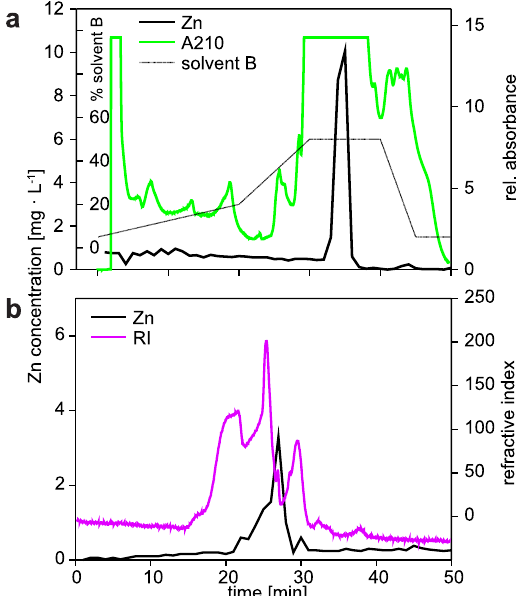
Figure 4. HPLC separation profile with ( a ) NH 2 -column of pooled zinc-containing low molecular weight fractions of gel chromatography showing absorptions at 254 nm (green line), Zn concentration (thick black line) and solvent gradient (thin black line), ( b ) with Superdex peptide 10/300 GL column of pooled zinc-containing fractions after amino column separation and vacuum concentration with Speedvac. Pink line corresponds to refractive index signal while black line is zinc